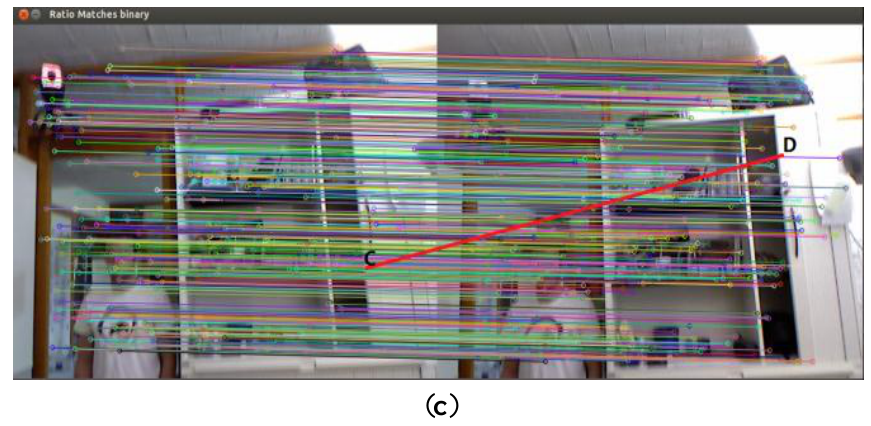
Figure 7. Feature matching results for Bidirectional FLANN KNN method and Homography transformation. ( a ) Forward FLANN KNN Filtration, ratio of 0.6; ( b ) Reverse FLANN KNN Filtration, ratio of 0.6; ( c ) Bidirectional FLANN KNN Filtration, ratio of 0.6.